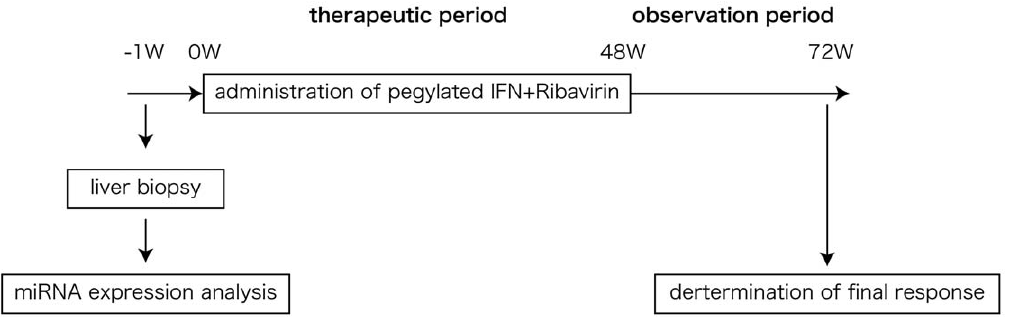
Figure 5. Study design and time line of response to combination therapy. The time frame of liver biopsy, microarray analysis, therapeutic period, observation period after combination therapy, and the judging of clinical outcome is